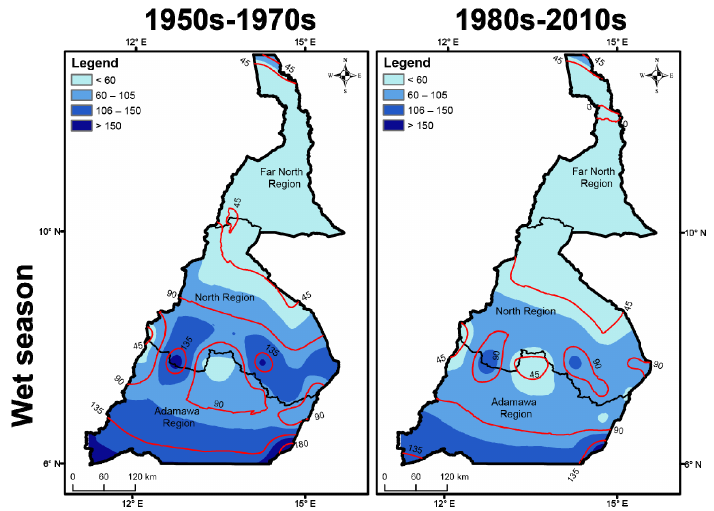
Figure 8. Spatial distribution of mean rainfall for the northern regions of the country (Adamawa,